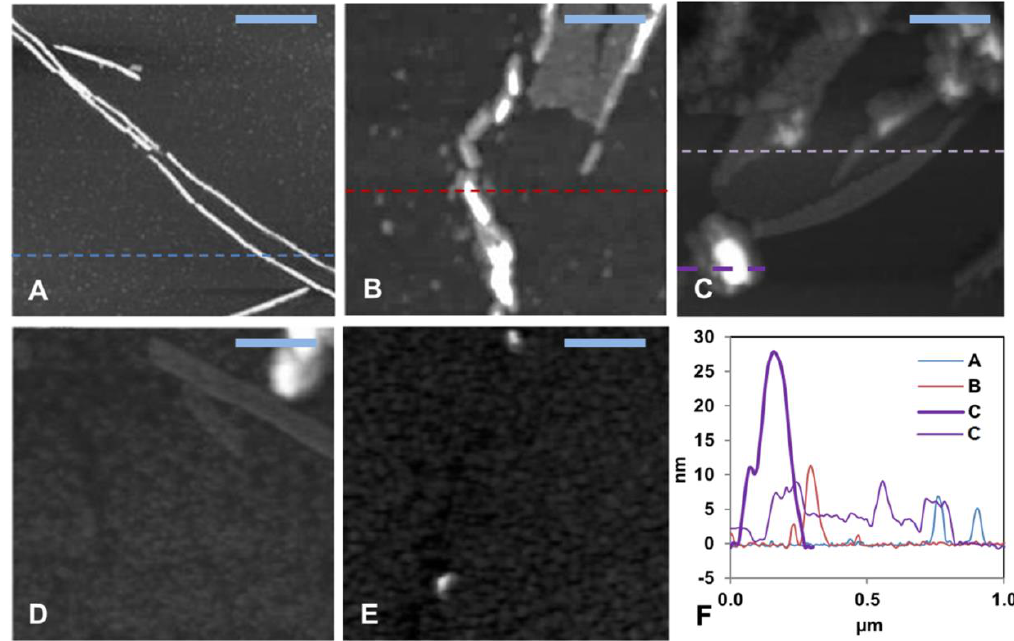
Figure 2. Solid-state AFM imaging of A β 40 fibril formation and morphology. ( A – D ) Topographical images of samples taken from the end of the ThT aggregation experiment (~45 h) in Figure 1. ( A ) shows 15 µ M aggregated A β 40 peptides alone, ( B ) A β 40 + 0.8 µ M Hg(II) ions, ( C ) A β 40 + 1.5 µ M Hg(II) ions, ( D ) A β 40 + 3.0 µ M Hg(II) ions, ( E ) A β 40 + 15 µ M Hg(II) ions, and ( F ) shows cross sectional height information from the images in ( A – C ). The scale bars represent 0.25 µm.